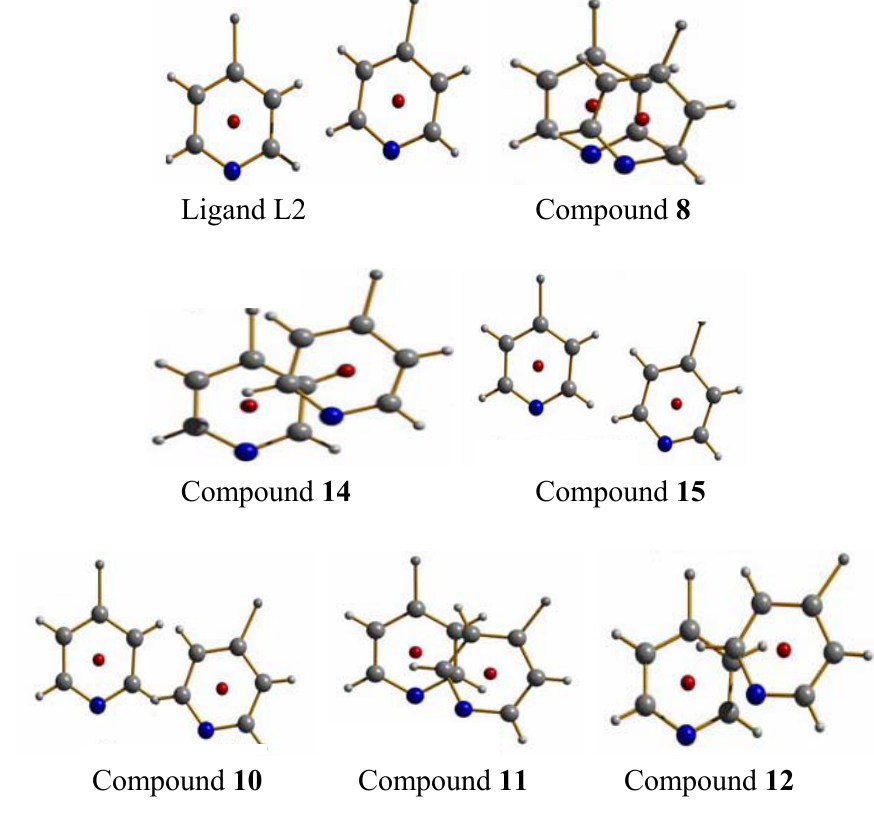
Figure 16. Relative positions of the pyridyl units of the ligand L2 of the different compounds (centroids in